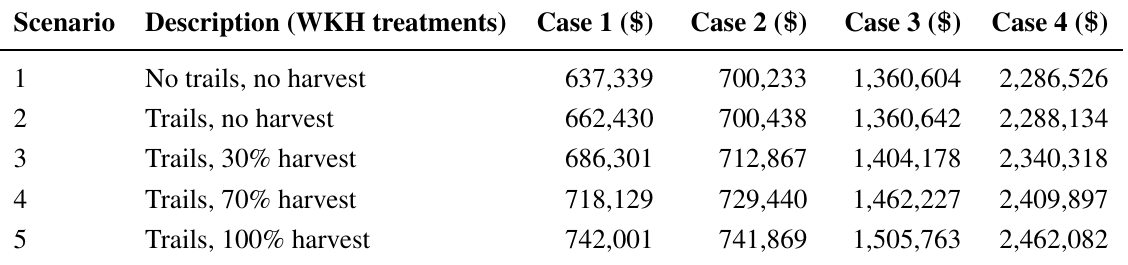
Table 2. Objective values for scenarios and cases. WKH, woodland key